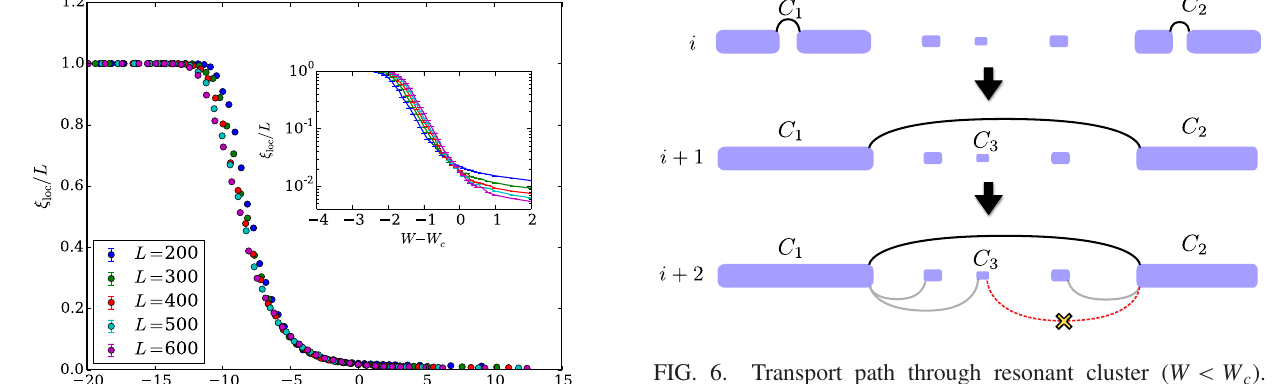
FIG. 6. Transport path through resonant cluster ( W < W c ). Schematic depiction of the sequence of resonance-merging steps ( i; i þ 1 ; i þ 2 ) that produces a gap in the transport path through the resonant cluster. See text for a detailed explanation. Blue rectangles are resonantly linked clusters of spins. Black and gray lines indicate resonant links between previously formed clusters. The dashed crossed-out red line indicates a spurious connection that should not be added to the transport path of the